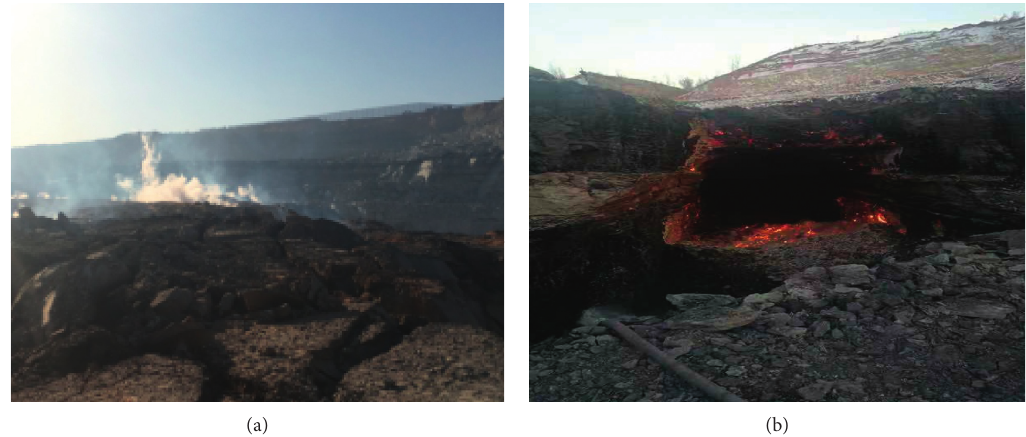
Figure 1: Environmental pollution caused by spontaneous combustion of coal. (a) Flue gas produced by spontaneous combustion. (b) Exposed open flame after peeling off the surface.